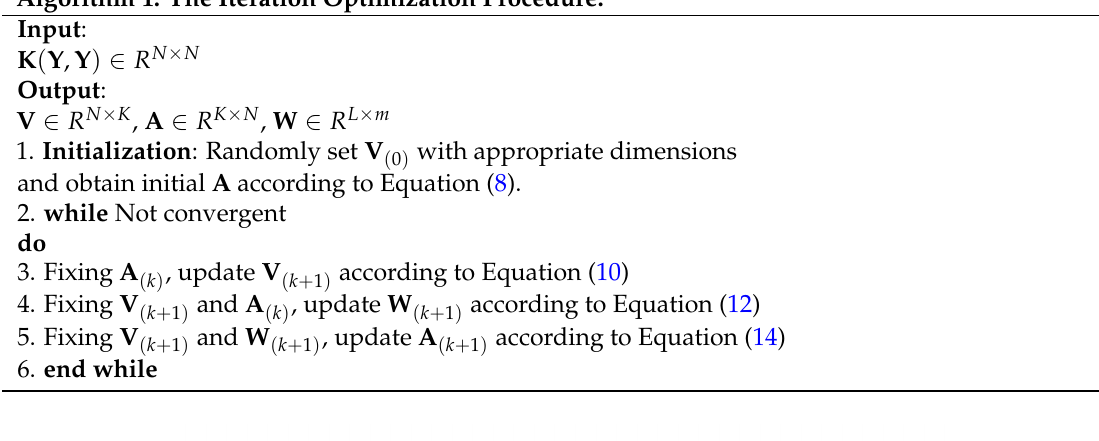
Algorithm 1. The Iteration Optimization Procedure.